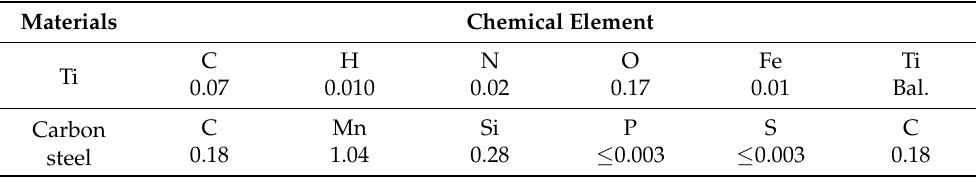
Table 1. The chemical composition of Ti and carbon steel materials (wt.%).